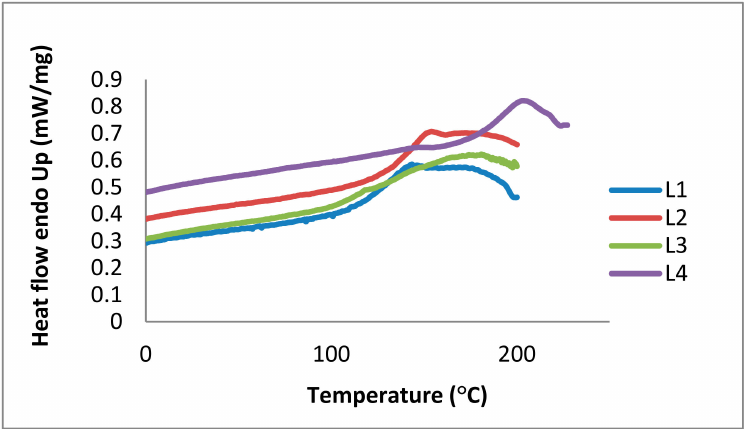
Figure 10. Differential scanning calorimetry (DSC) curves of the kraft lignin purification fractions L1 (blue), L2 (red), L3 (green), and L4